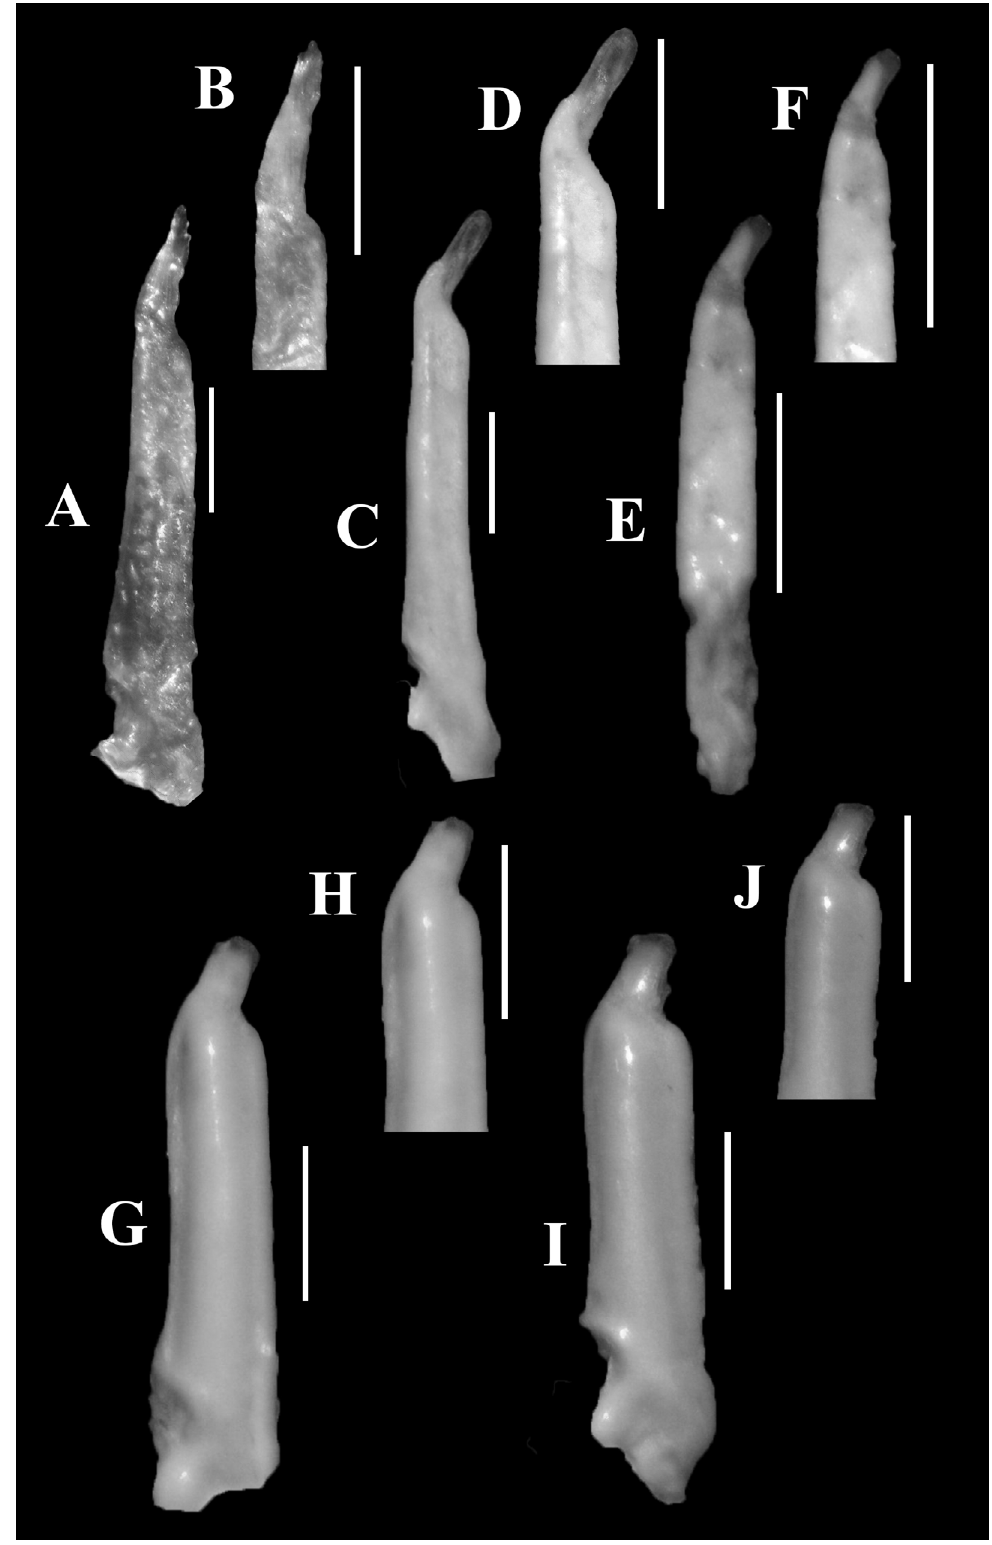
Figure 7. Nanosesarma G1 ventral view. ( A , B ) N. andersoni (De Man, 1888), male (CL: 4.8 mm; CW: 6.5 mm), (LFSC.ZRC-185); ( C , D ) N. batavicum (Moreira, 1903), male (CL: 4.8 mm; CW: 6.6 mm) (GUMSIS1); ( E , F ) N. minutum (De Man, 1887), male (CL: 4.8 mm; CW: 5.9 mm) (LFSC.ZRC-186); ( G , H ) N. sarii Naderloo and Türkay, 2009, male (CL: 5.6 mm; CW: 6.6 mm) (LFSC.ZRC-188); ( I , J ) N. jousseaumei (Nobili, 1906), male (CL: 4.8 mm; CW: 5.5 mm) (LFSC.ZRC-187); (A, C, E, G, I) ventral view of left G1; (B, D, F, H, J) ventral view of distal part of left G1 (setae removed). Scale bars = 1